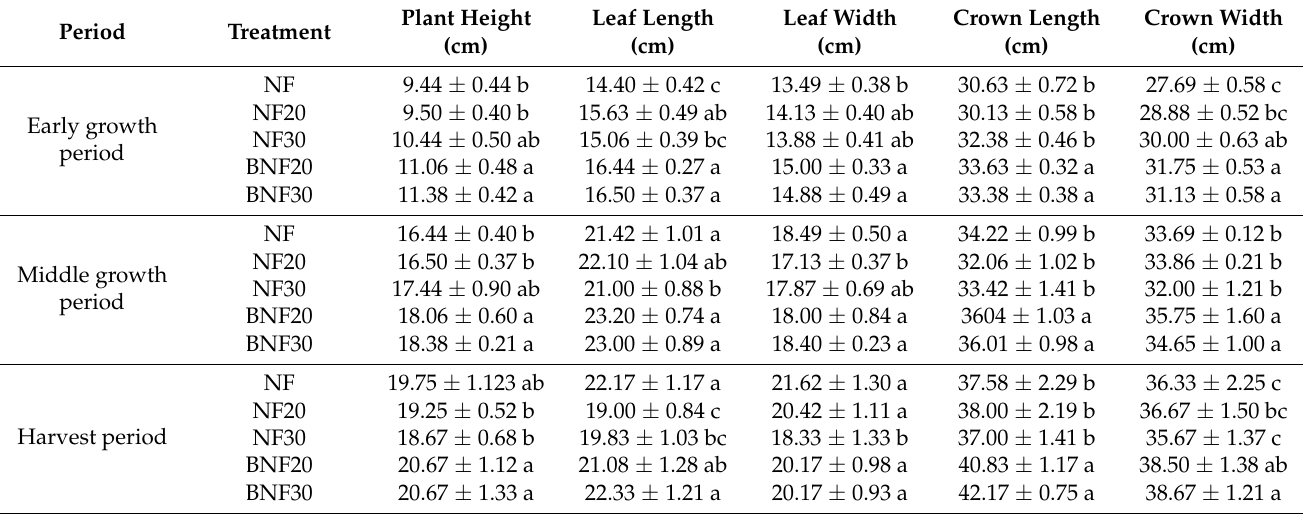
Table 4. Effects of different fertilization treatments on growth index of ‘yellow rose’ cabbage.